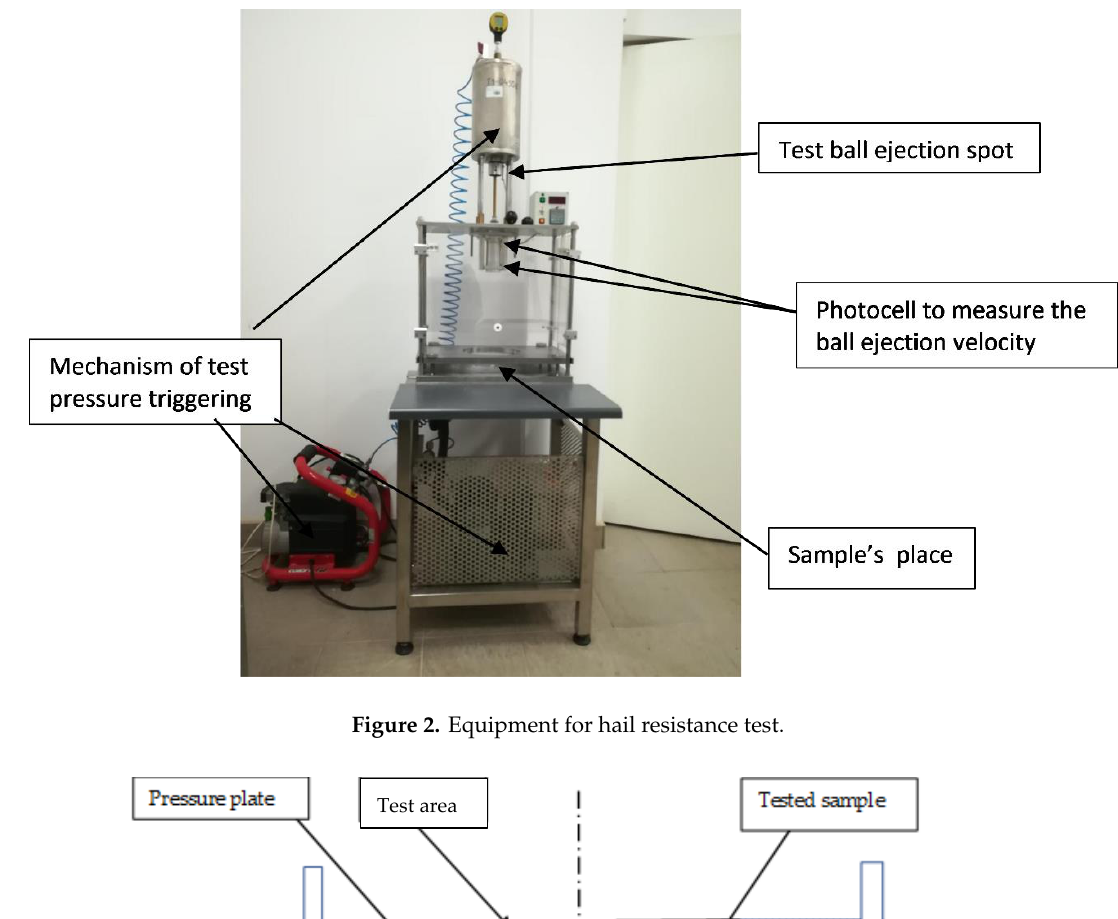
Figure 2. Equipment for hail resistance test.